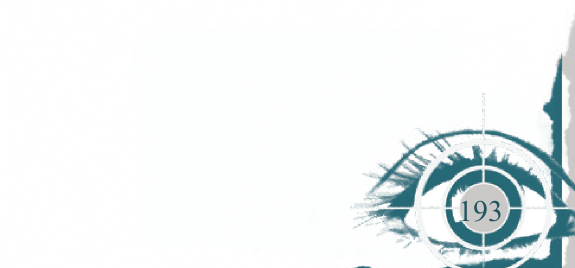
The South African